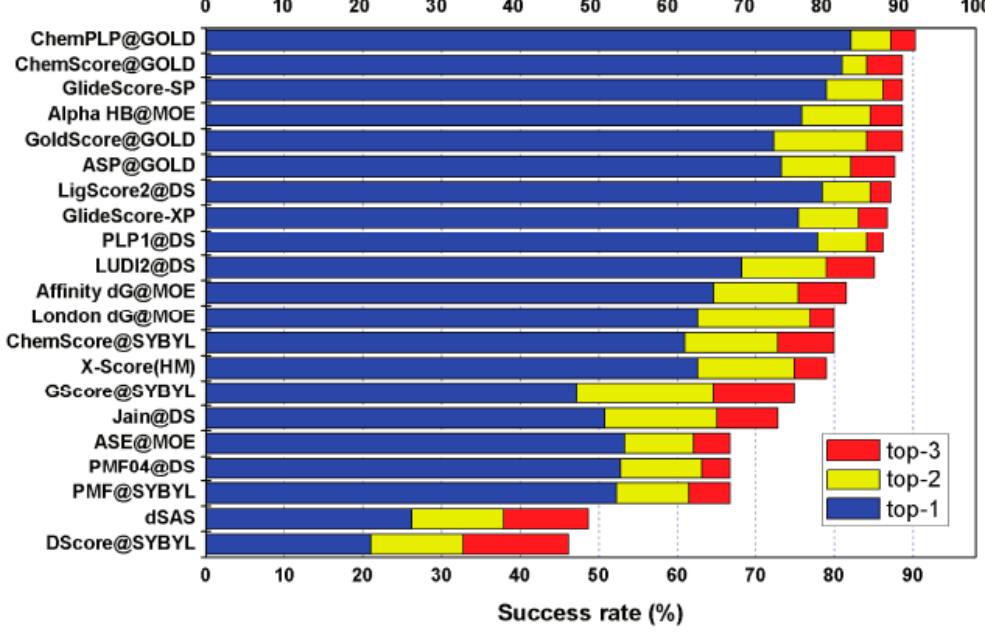
Figure 2. The results diagram of 21 scoring functions in CASF [52].